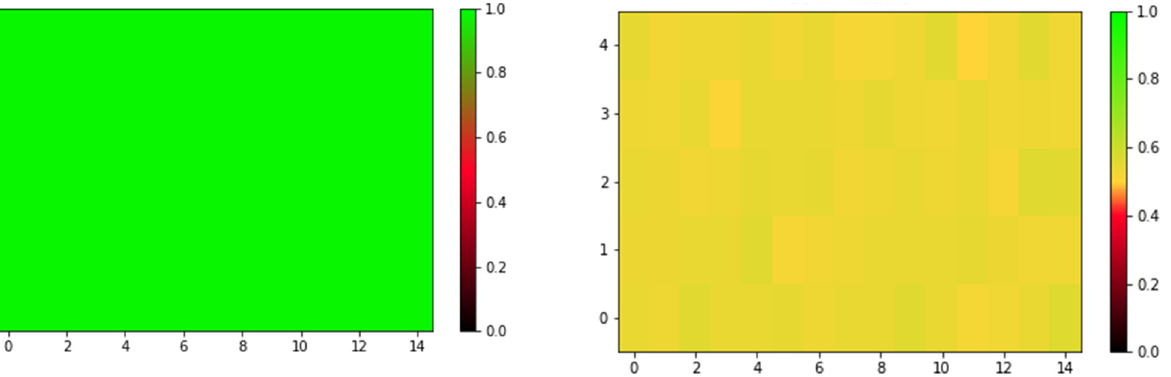
Figure 8. Remaining warranty ( left ) and remaining health ( right ) of each of the battery modules in the battery system.